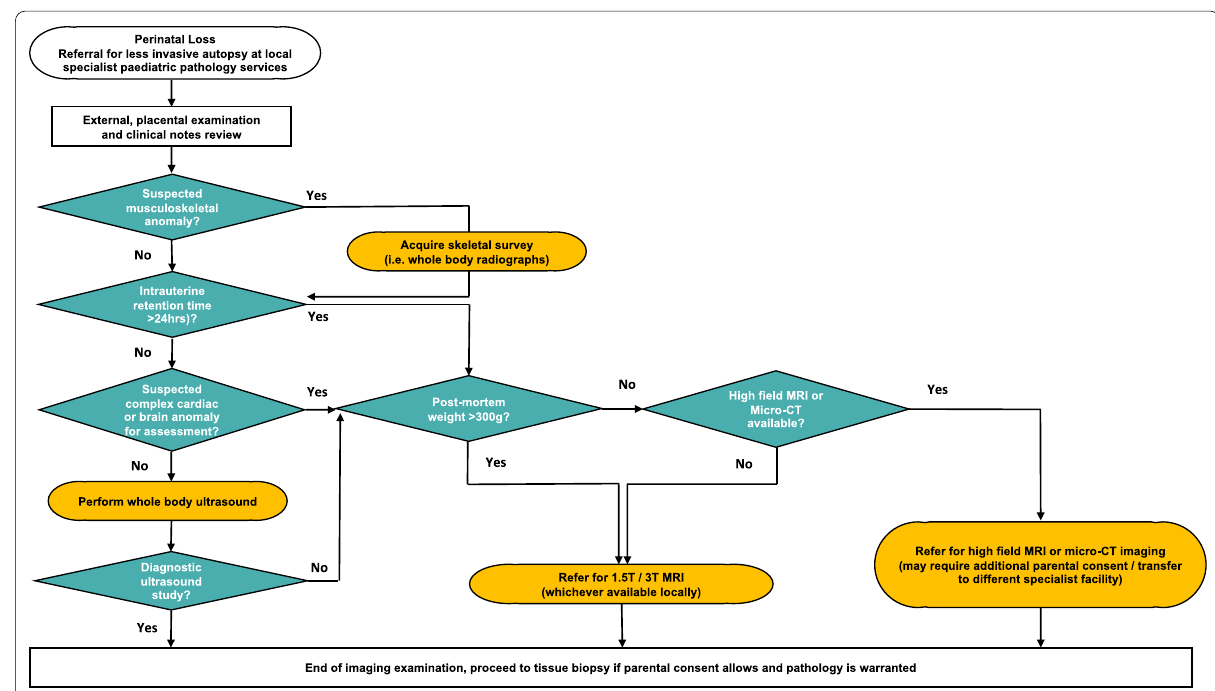
Fig. 4 Recommended post-mortem imaging flowchart for non-invasive investigation of perinatal loss. Small foetuses present a challenge for post-mortem imaging, and care should be taken when interpreting imaging results in this cohort. A foetus weighing over 500 g provides the greatest likelihood for a diagnostic quality 1.5 T MRI study [14], and those weighing < 300 g are best suited for micro-CT or high-field MRI [32]. Where neither MRI nor micro-CT is available, ultrasound may be attempted but there is a higher likelihood of a false or non-diagnostic result [26, 58]. Foetuses weighing between 300 and 500 g have been reported to take > 7 days to iodinate and therefore delay micro-CT imaging. If available, 3 T MRI could be attempted for this foetal cohort